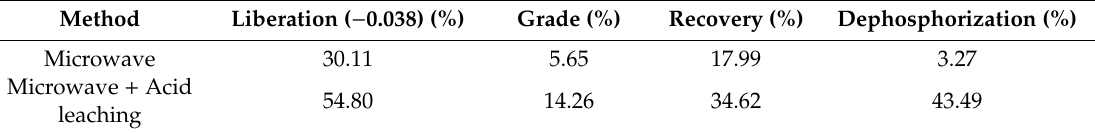
Table 3. Improvement in hematite liberation, iron grade, recovery, and dephosphorization [71].